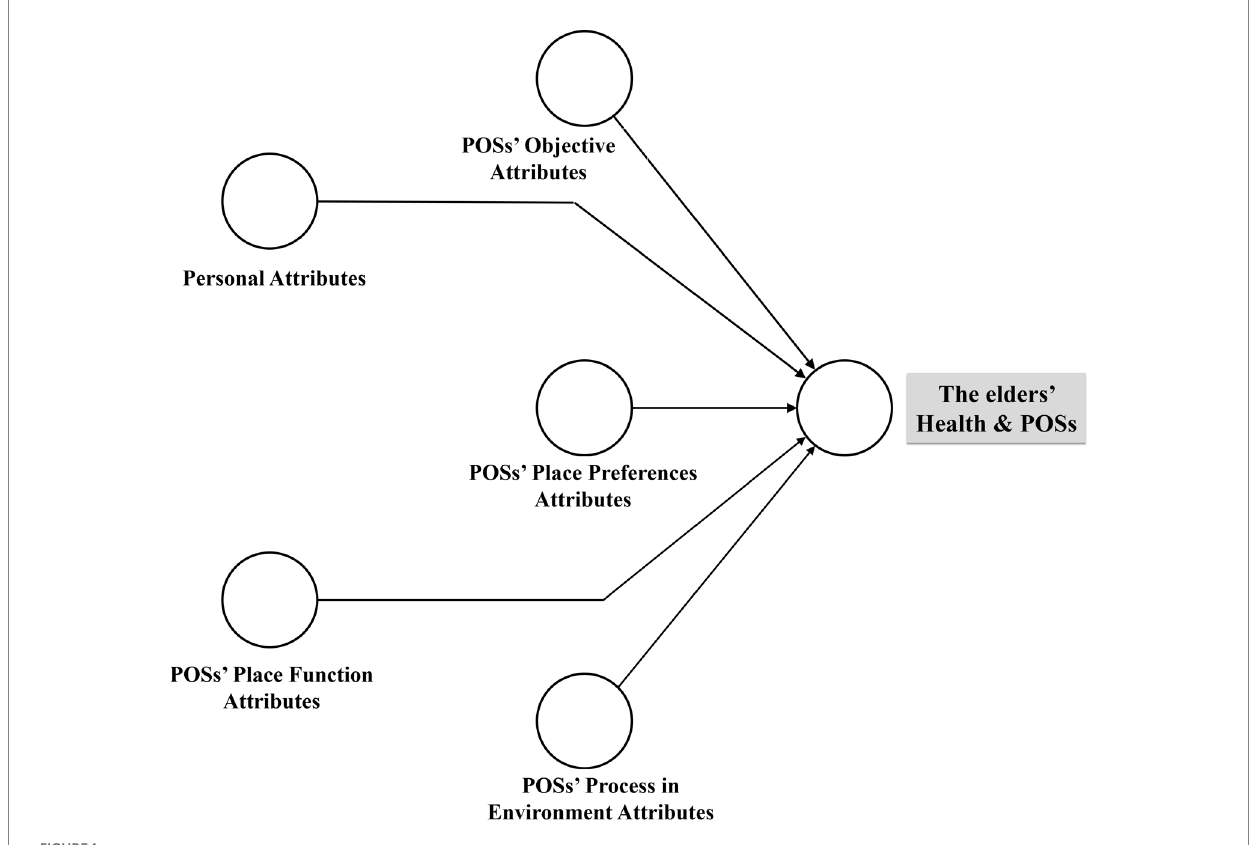
FIGURE 1 The proposed conceptual